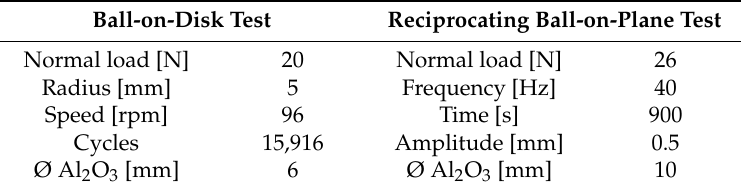
Table 3. Setting parameters for the wear tests.